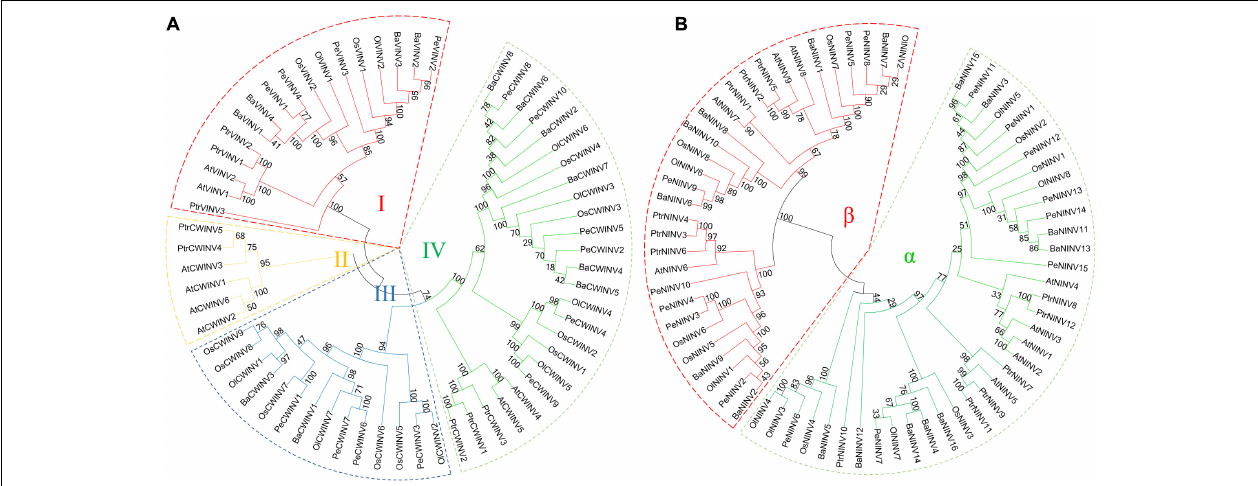
FIGURE 5 | Phylogenetic tree of INVs in bamboo and other plants. (A) Acid invertase (CWINV and VINV). (B) Neutral/alkaline invertase (NINV). The phylogenetic tree was constructed via the neighbor-joining method (1,000 bootstrap replicates) using MEGA 7.0 software. The Pe, Ba, Ol, Os, At, and Ptr indicate invertase genes of Phyllostachys edulis , Bonia amplexicaulis , Olyra latifolia , Oryza sativa , Arabidopsis thaliana , and Populus trichocarpa ,